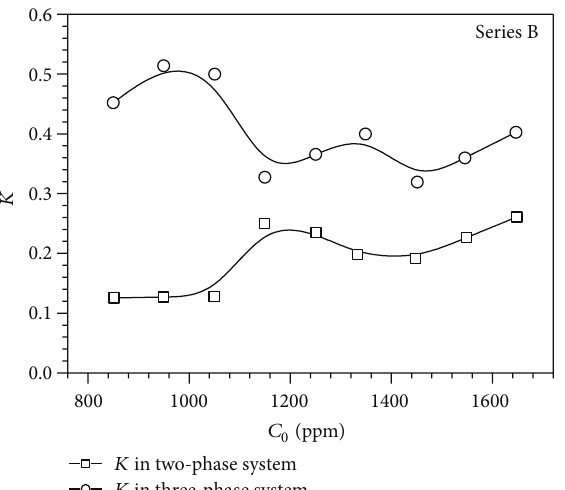
Figure 8: The distribution coefficient in water-oil system in the simulative water